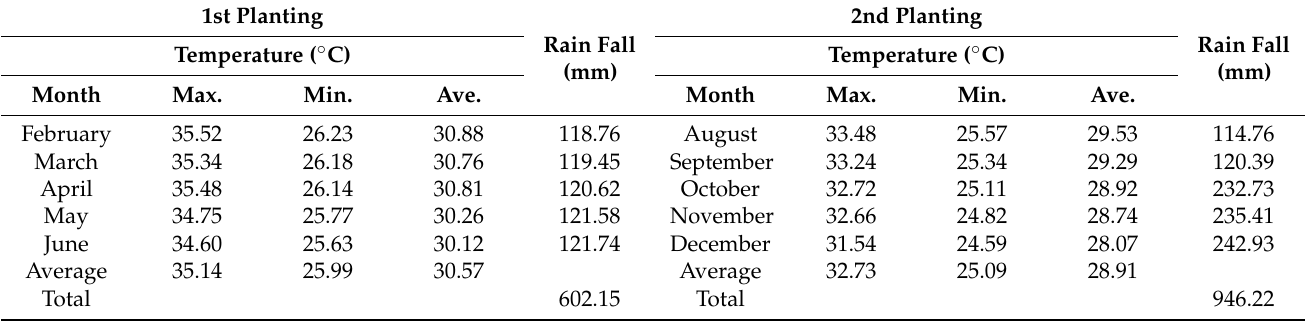
Table 2. Month-wise average of daily maximum temperature, minimum temperature, mean temperature, and rainfall at UPM during experimentation period from February to June (1st planting season) and from August to December (2nd planting season)